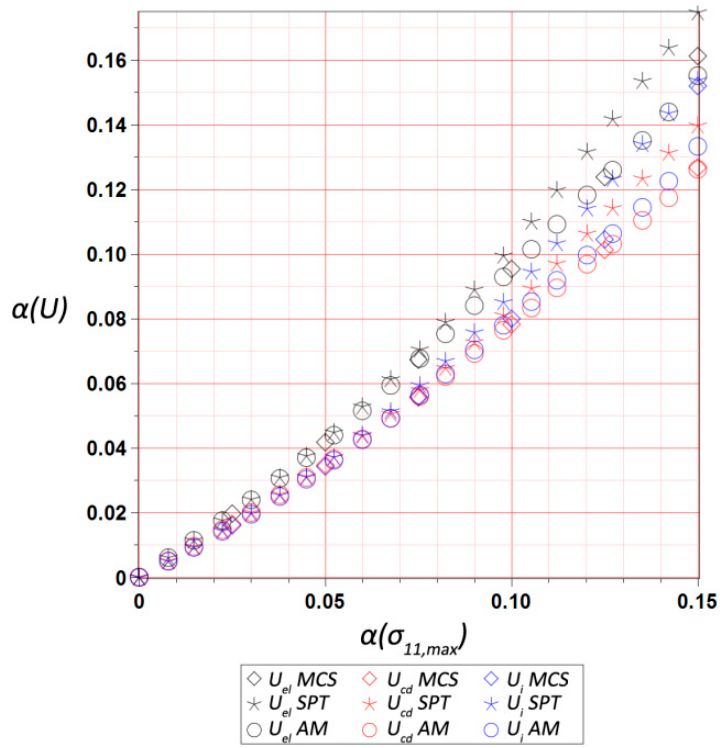
Figure 10. Coe ffi cient of variation of ultimate elastic strain U el , dissipation U cd , and internal U i energies Figure 10. Coefficient of variation of ultimate elastic strain 𝑈 (cid:3032)(cid:3039) , dissipation 𝑈 (cid:3030)(cid:3031) , and internal 𝑈 (cid:3036) (cid:17) (cid:16) σ in the RVE vs. α 11, max energies in the RVE vs. 𝛼(cid:3435)𝜎 (cid:2869)(cid:2869),(cid:3040)(cid:3028)(cid:3051) (cid:3439) .